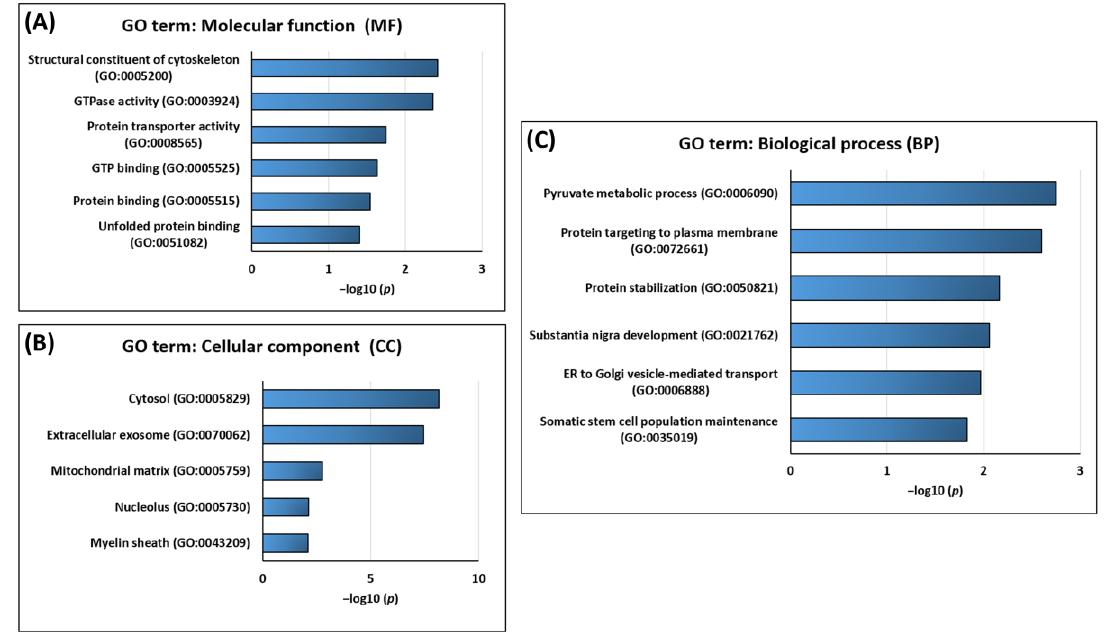
Figure 4. GO enrichment analysis of all HTRA2-specific protein interaction partners. Negative log10-adjusted p -values ( p < 0.05) for the significantly enriched GO terms are shown for the molecular function ( A ), the cellular component ( B ), and the biological process ( C ) of all